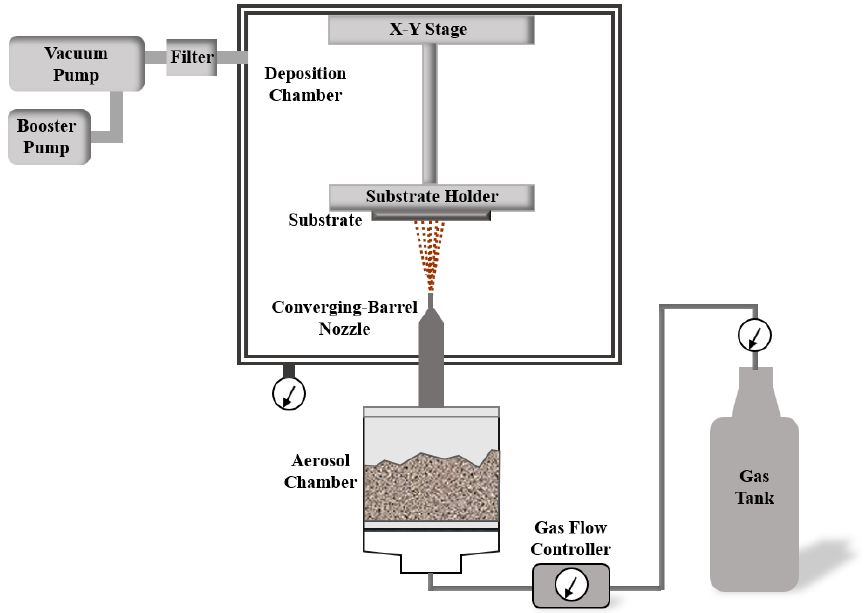
Figure 1. Schematic diagram of the aerosol deposition system.